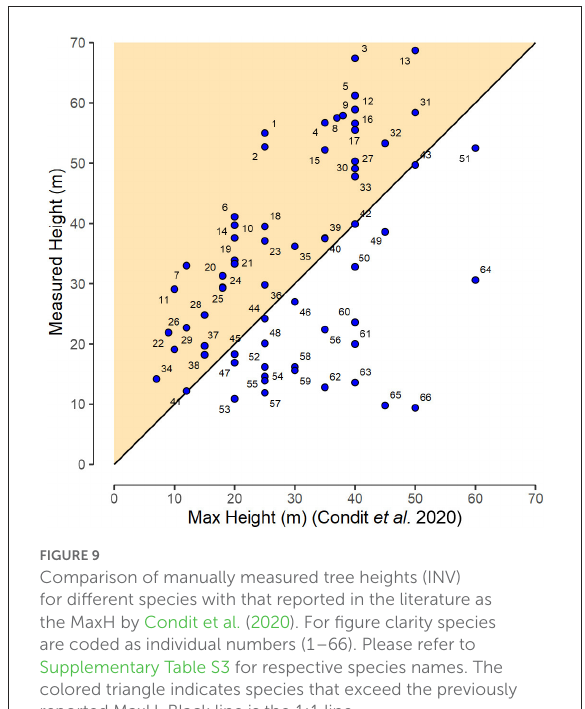
Across the 20 inventory plots, very large trees (DBH ≥ 150cm) belong to 11 species with A. excelsum (nine individuals) and D. oleifera (six individuals) being the most frequent.